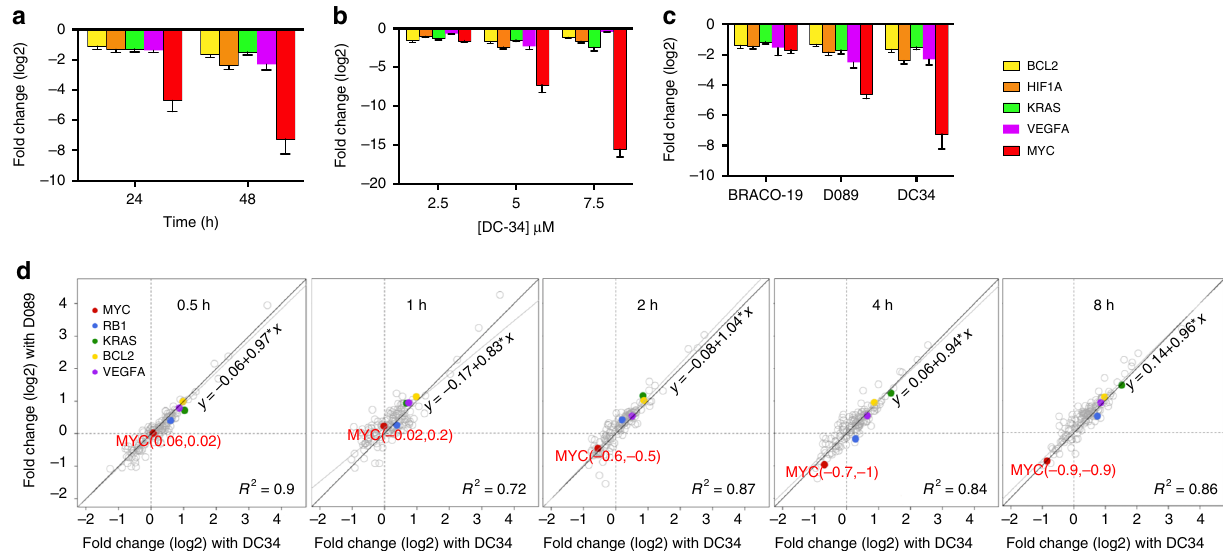
Fig. 4 Effects of DC-34 on gene expression. a qPCR analysis of the indicated G4 containing genes following 5 μ M treatment in L363 cells. b qPCR analysis of G4-associated genes at 48 h as a function of [DC-34]. c qPCR analysis of G4-associated genes after 48 h treatment with Braco-19, a pan-G4 binder, D089, a MYC G4 analog, and DC-34 at the indicated doses in L363 cells. Data in a – c are the average log 2 values for ΔΔ C t of three replicates in L363 cells. d Effects of D089 (15 µ M) and DC-34 (5 µ M) on expression of genes (Nanostring) at the indicated time points. G4 controlled genes including MYC (red) are highlighted in color. Fitted linear regression lines (solid) for gene expression and identity lines (dashed) for drugs are indicated